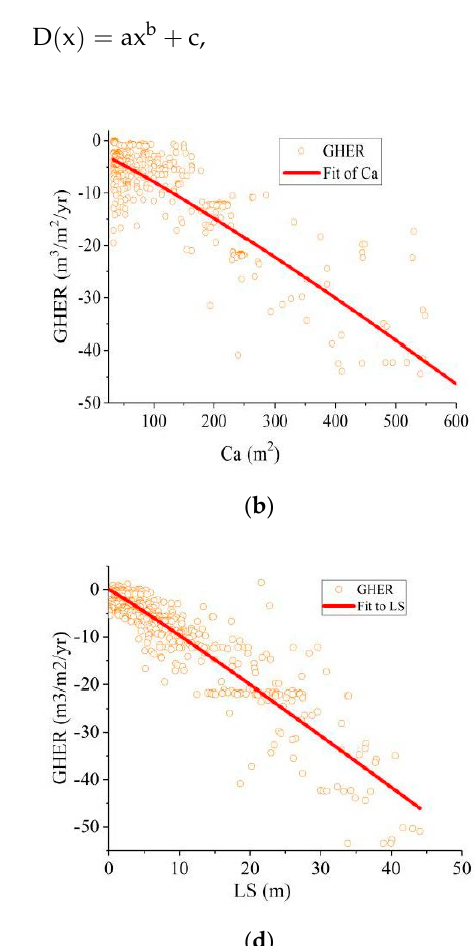
Table 3. Single factor parameters based on power function fitting.